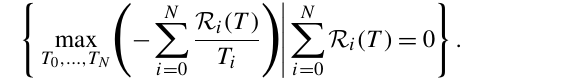
Figure 1. Discretization of an atmospheric column into N layers. The layer i – at temperature T i , fixed pressure P i , elevation z i (which depends on the temperature profile), and mixing ratio q i – has a specific energy e i = C p T i + gz i + Lq i ; m i is the mass mixing coefficient between layers i − 1 and i which leads to the net energy flux F i = m i ( e i − 1 − e i ); R i is the net radiative energy budget in the layer i . The ground is represented by layer 0 with fixed surface albedo α